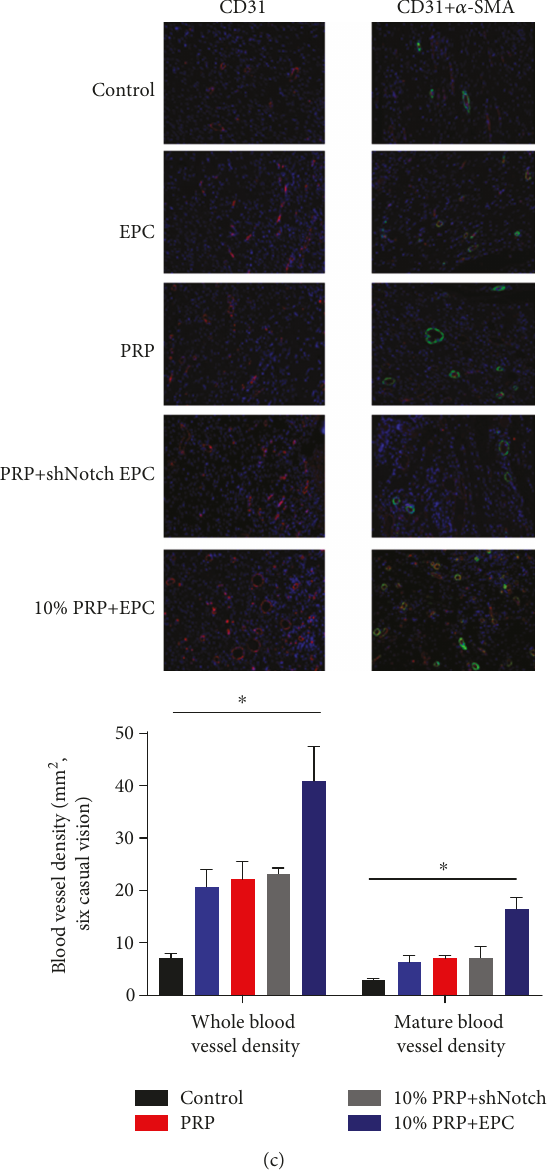
Figure 4: In vivo test. (a) Wound situation and wound size, immediately after operation and at days 4, 7, and 14. Treatment groups showed a signi fi cant di ff erence compared with the control group, ∗ p < 0 05 . (b) H&E and Masson staining of specimens at day 14. (c) CD31 and α -SMA immunostained samples of rats at day 14. ∗ p < 0 05 for the treatment groups vs. the control